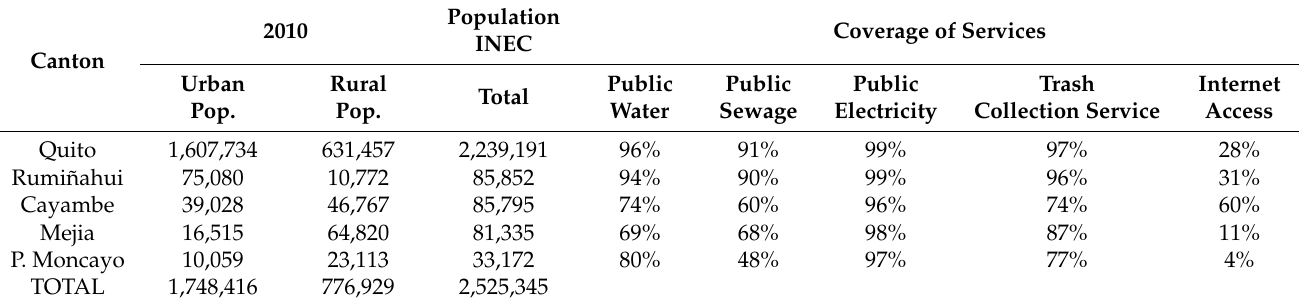
Table 1. Population by canton and coverage of basic